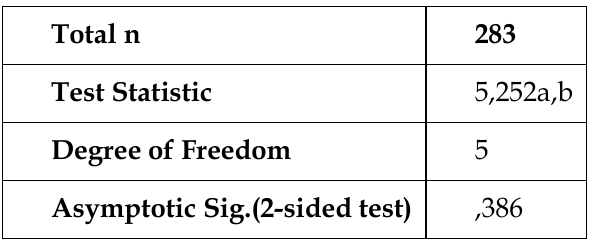
Table 5. Concern about breaching personal privacy and age. Kruskal-Wallis sig. test. The test statistic is adjusted for ties.